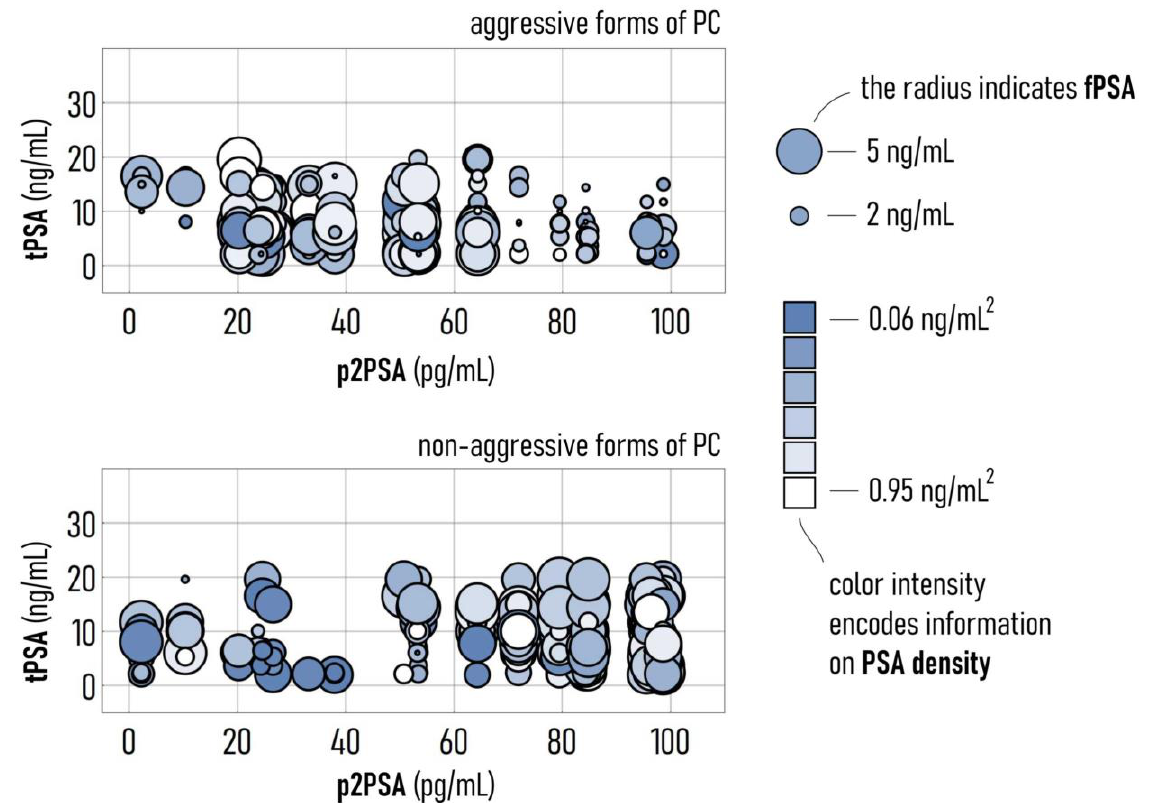
Figure 4. Visual representation of the output of the AI model as a function of the values of the clinical variables tPSA, fPSA, p2PSA, and PSA density. In the upper (lower) row, we report the combination of variables associated with aggressive (non-aggressive) forms of PC, with GS ≥ 7 ( GS < 7).